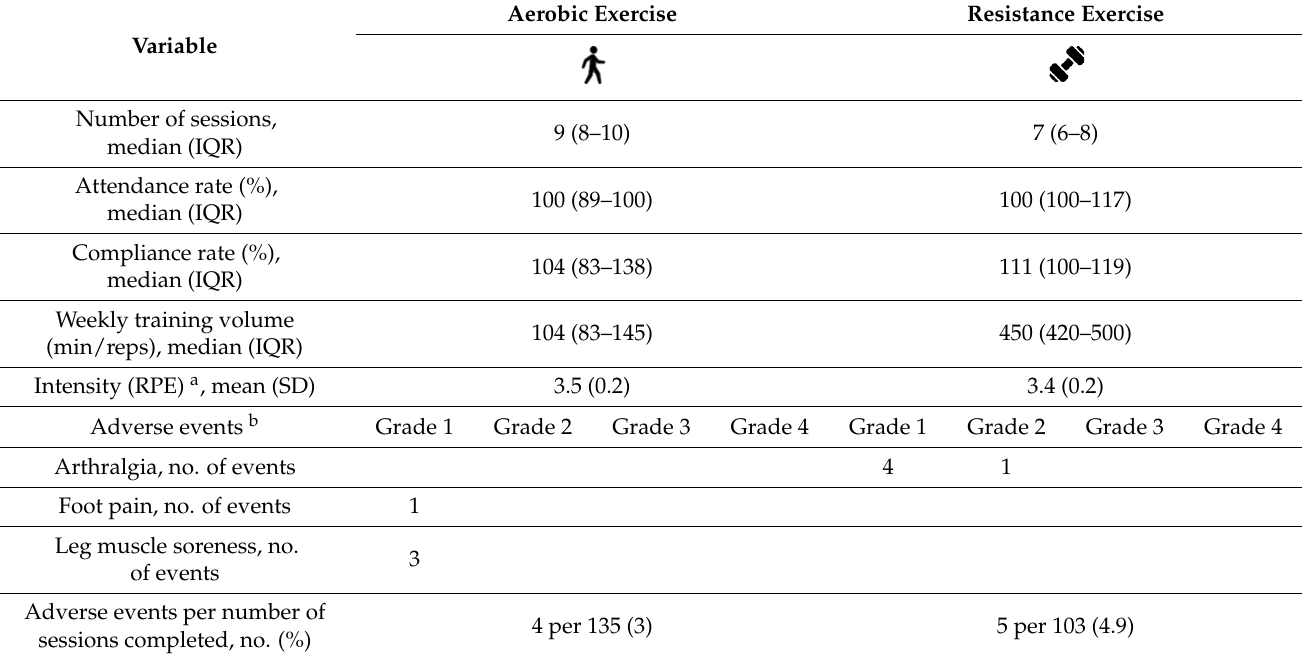
Table 2. Exercise adherence and adverse events.